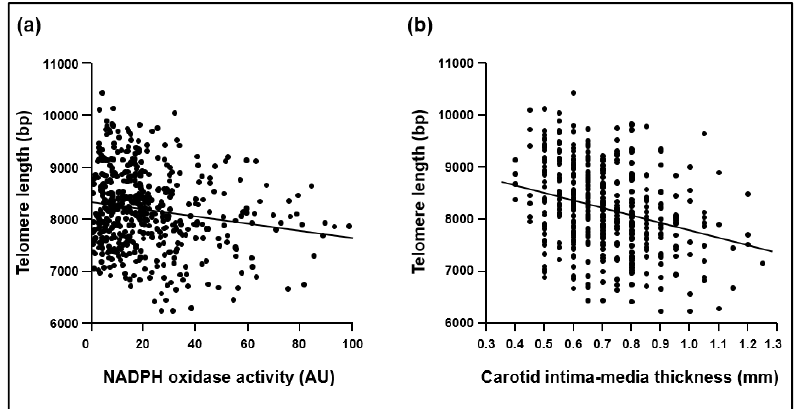
Figure 2. Inverse correlation of telomere length with ( a ) NADPH oxidase activity (R = − 0.255, p < 0.001 after correcting it for age and sex) and ( b ) carotid intima-media thickness (R = − 0.173, p < 0.001 after correcting it for age and sex) in all the asymptomatic population. bp, base pairs. AU, arbitrary units. Table 2. Demographical and clinical characteristics of the cohort 2 .